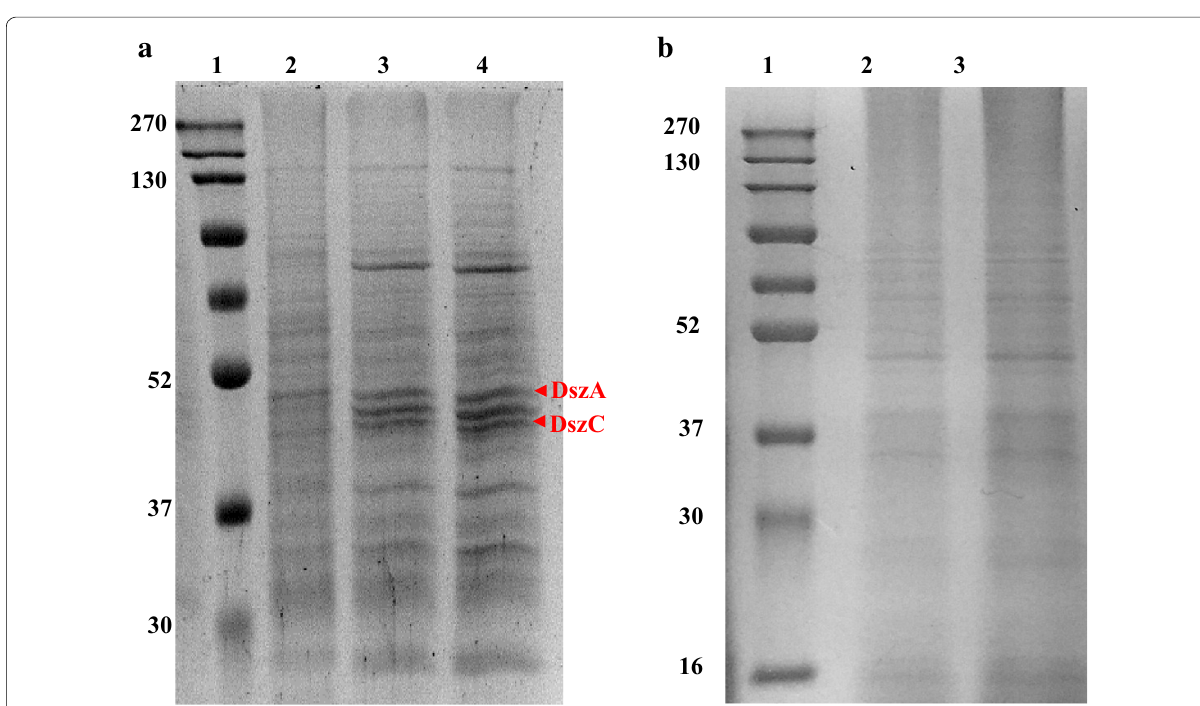
Fig. 7 a A 12% SDS-PAGE gel showing expression of Dsz proteins (DszA ~ 52 kDa, DszC ~ 45 kDa) in presence of the TetR family protein when the cells are grown in DBT containing medium. Lane1: marker, lane2: Wild type Gordonia (sonicated supernatant), lane3: Gordonia transformed with the TetR family protein uninduced (sonicated supernatant), lane4: Gordonia transformed with the TetR family protein induced (sonicated supernatant). The proteins were identified by MALDI-ToF. b A 12% SDS-PAGE gel showing the expression of Dsz proteins when cells are grown in DBT containing medium. Lane1: marker, lane2: Wild type Gordonia (sonicated supernatant) when induced with IPTG at Day 0, lane 3: Wild type Gordonia (sonicated supernatant) when induced at OD 600 is 0.5. Induction of the dsz enzymes are not observed in absence of the TetR family